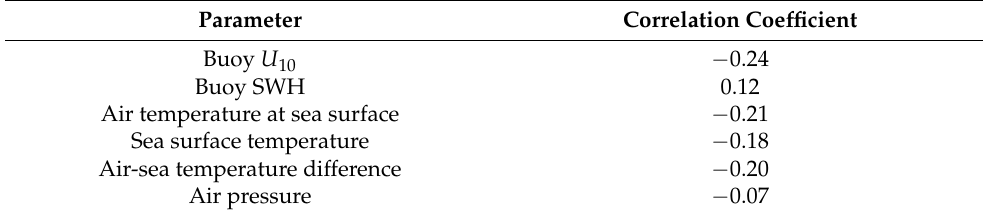
Correlation coefficients between U 10 residuals (ASCAT minus buoy) and various oceanic/atmospheric